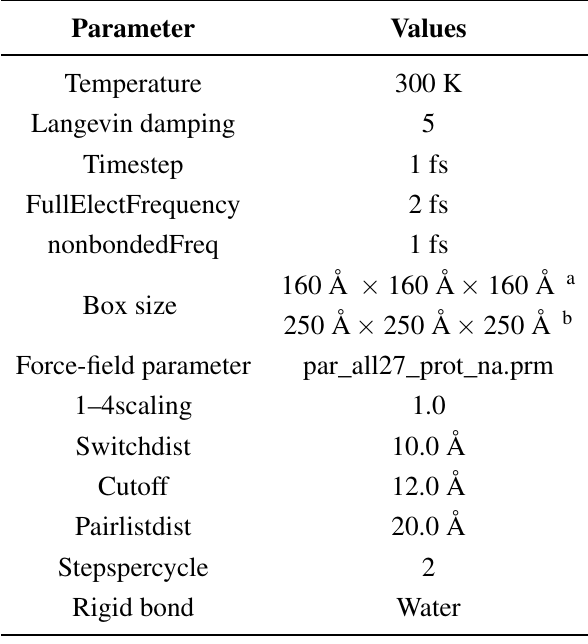
Table 1. Input parameters for NAMD (NAnoscale Molecular Dynamics)